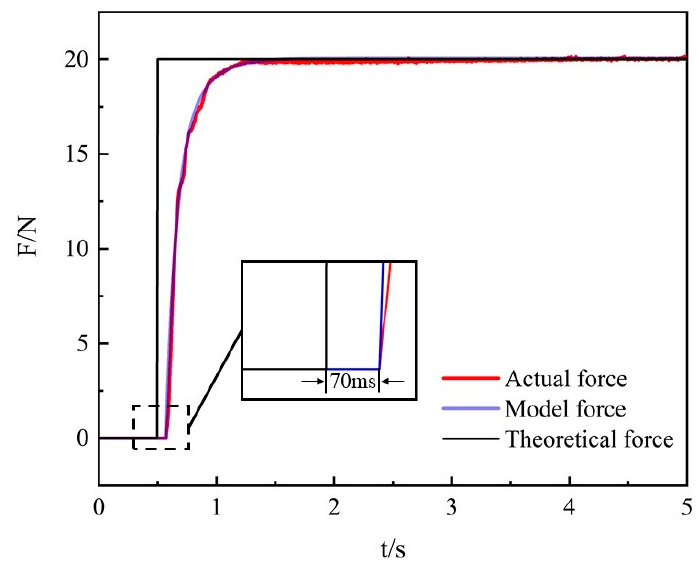
Figure 5. Comparison of the open-loop step response between the mathematical and actual models.